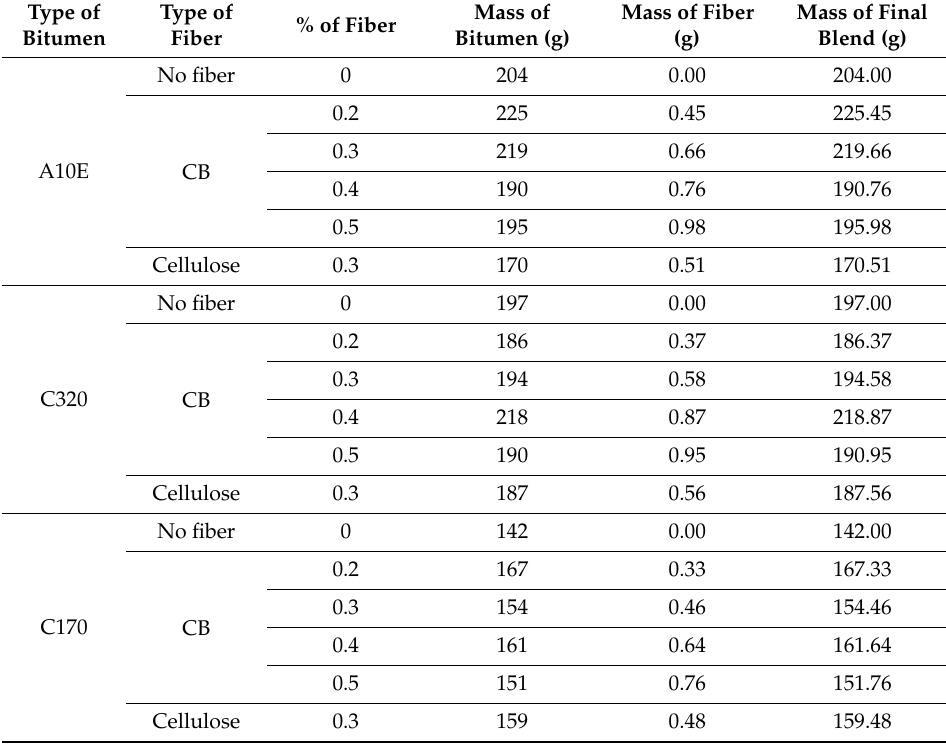
Table 3. Blending approach 2 for bitumen modified with cellulose fiber and cigarette butts. Type